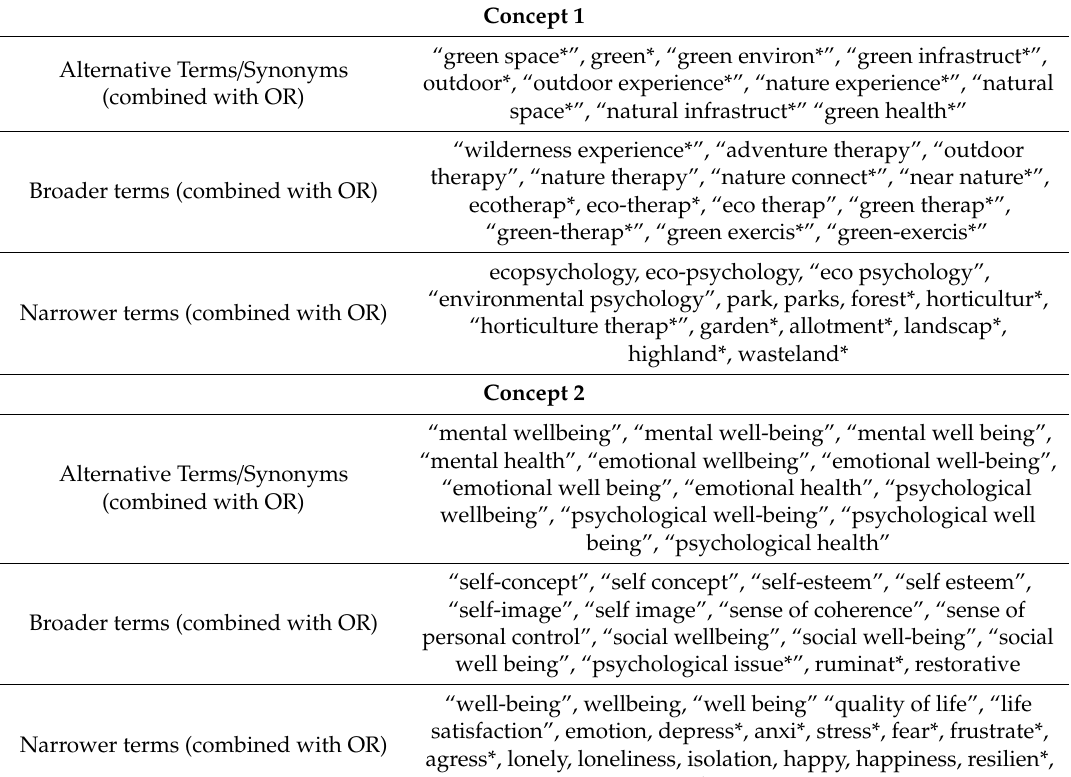
Table 1. Concept 1: Green space. Concept 2: Mental health and